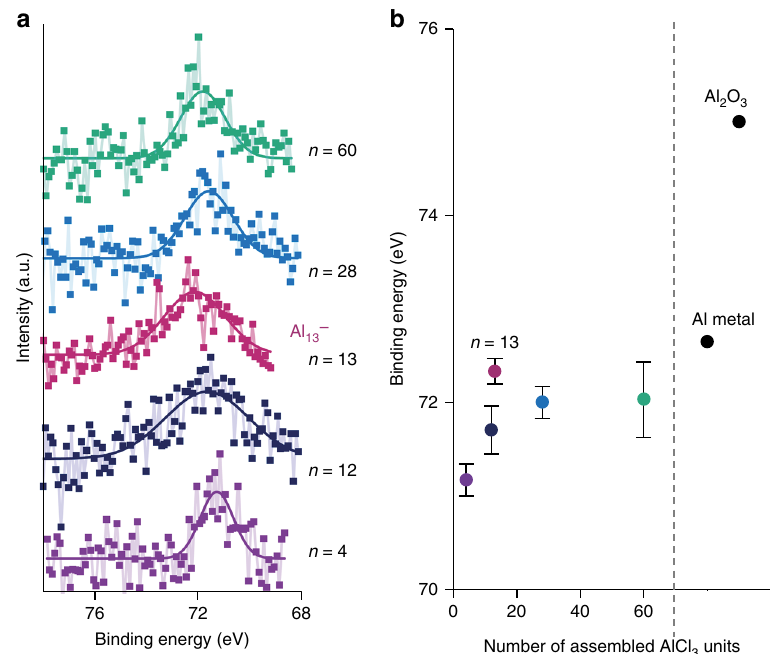
Fig. 2 X-ray photoelectron spectroscopy results of the aluminum clusters. a XPS spectra and b binding energies of the Al n cluster samples, aluminum metal and Al 2 O 3 . n ( = 4, 12, 13, 28, and 60) is the number of assembled AlCl 3 units in the DPAs. Error bars in b stand for the standard deviation of the mean